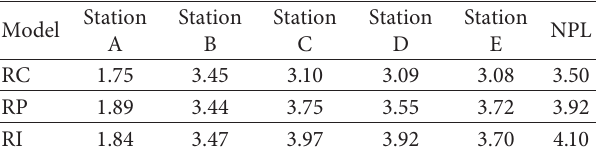
Table 2: NPL and loads corresponding to stations A to E on load- deflection